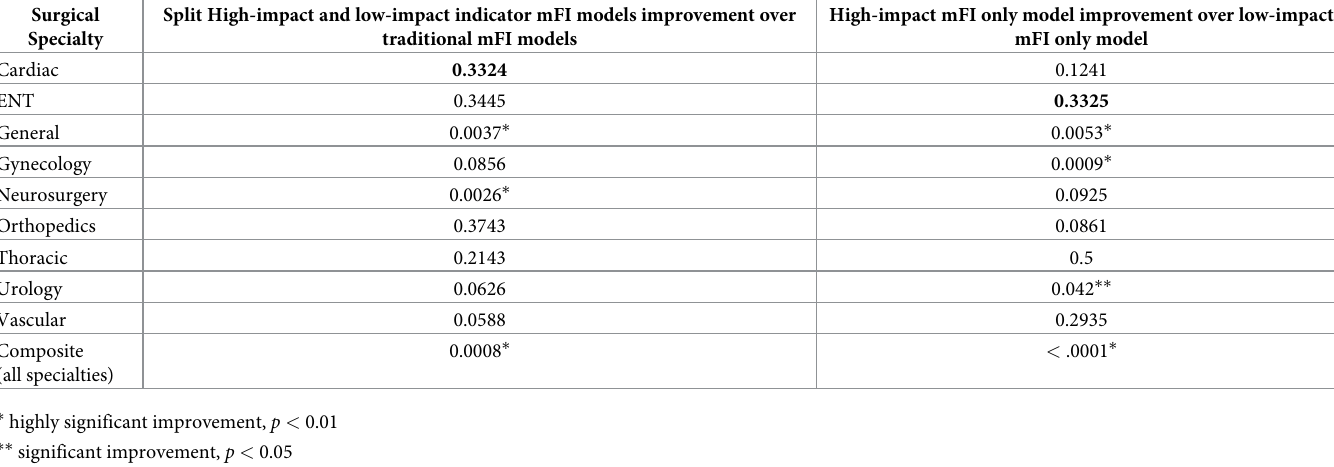
Table 3. Statistical significance of prediction accuracy differences, reported as p -values. Surgical